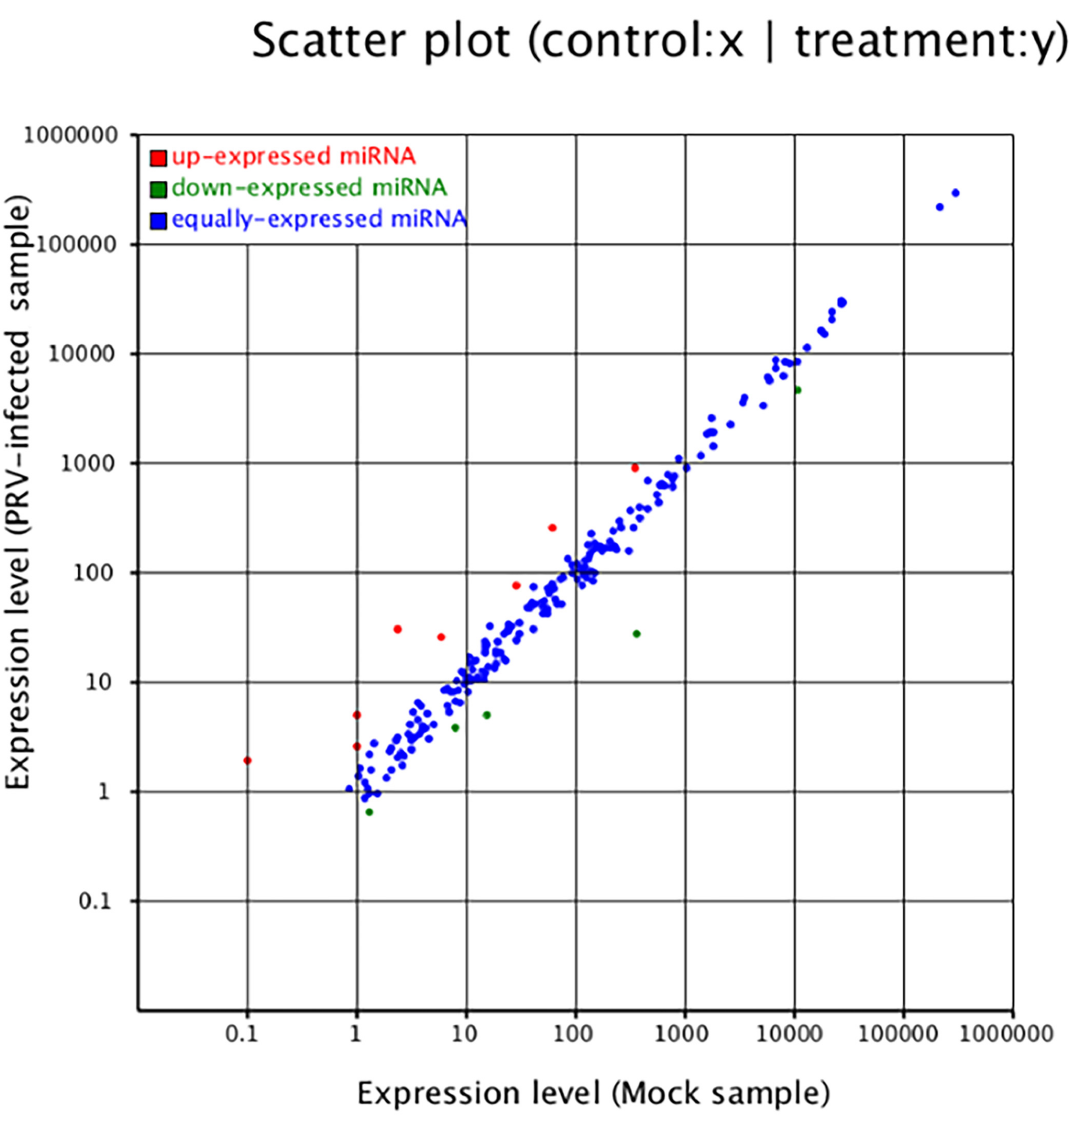
Fig 7. Differential expression of host miRNAs as a function of PRV JS-2012 infection. Red, miRNAs with ratio > 2 (infected/uninfected in expression); blue, miRNAs with 1/2 (cid:3) ratio (cid:3) 2; green, ratio <